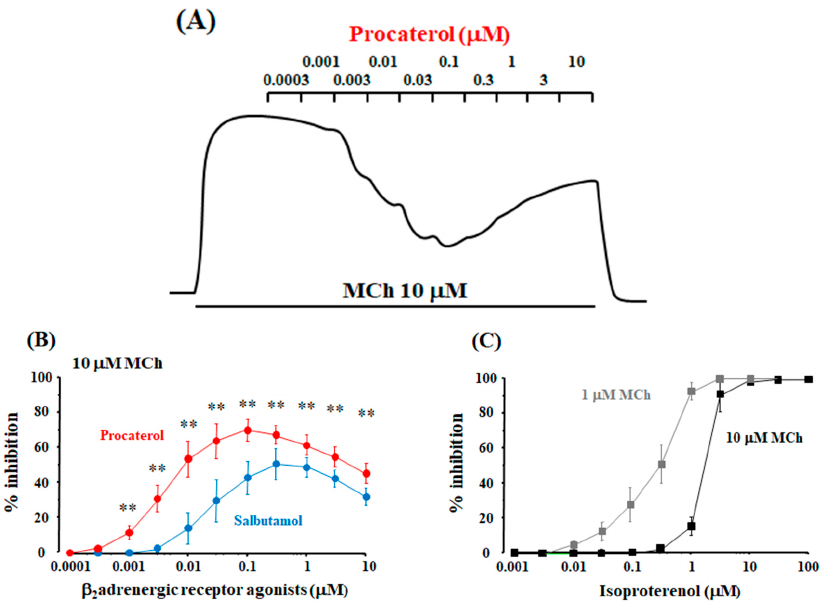
Figure 4. Effects of β 2 -adrenergic receptor agonists on muscarinic contraction via allosteric effects (efficacy modulation) in β 2 -adrenergic receptors. ( A ) A typical example of continuous recording of cumulative applications of procaterol to the tissues pre-contracted by 10 μ M MCh; ( B ) Concentration-inhibition curves for procaterol and salbutamol against contraction induced by MCh (10 μ M); ( C ) Concentration-inhibition curves for isoproterenol against contraction induced by MCh (1 and 10 μ M). MCh: methacholine. **: p < 0.01. Table 2. Pharmacological characteristics of β 2 -adrenergic receptor